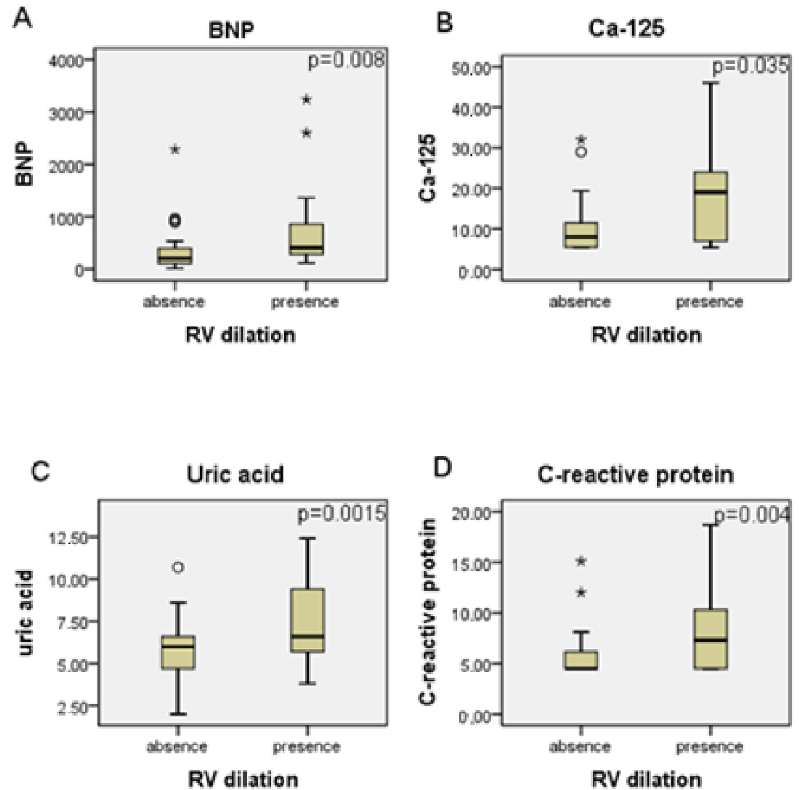
Figure 2. BNP, Ca-125, uric acid, C-reactive protein serum levels and RV dilation. ( A ) RV dilation (presence on echocardiogram) and BNP (bars represent median and 25th and 75th percentiles of circulating levels). ( B ) RV dilation (presence on echocardiogram) and Ca-125 (bars represent median and 25th and 75th percentiles of circulating levels). ( C ) RV dilation (presence on echocardiogram) and uric acid (bars represent median and 25th and 75th percentiles of circulating levels). ( D ) RV dilation (presence on echocardiogram) and C-reactive protein (bars represent median and 25th and 75th percentiles of circulating levels). *, group outliers; ° group outliers.